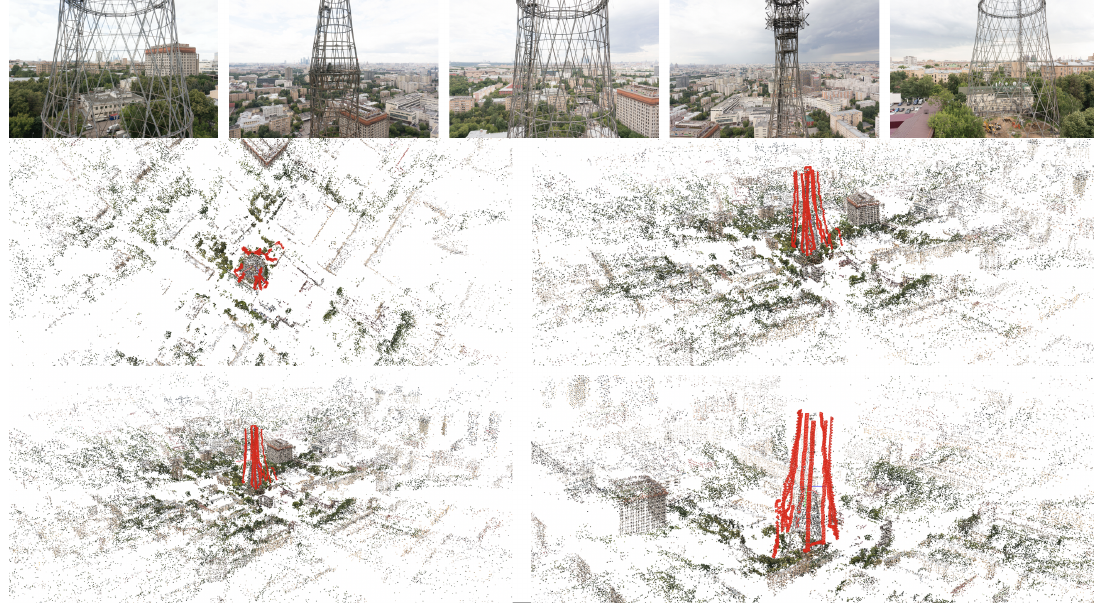
Figure 4. Some UAV images acquired to survey the tower (above). Different views of the recovered camera poses - red dots - and sparse point cloud